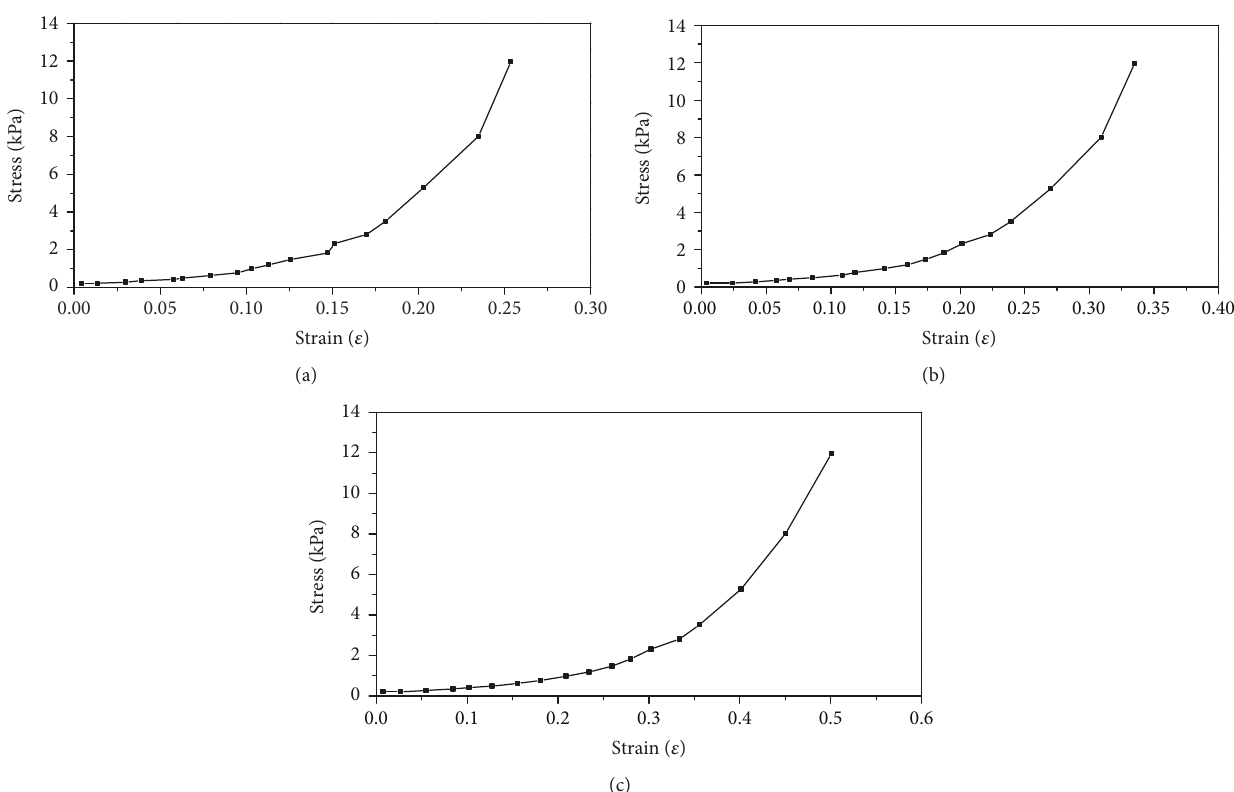
Figure 4: Mixture ’ s stress-strain relationship with di ff erent ratios: (a) sponge and foam 1: 3; (b) sponge and foam 1:2; (c) sponge and foam 1